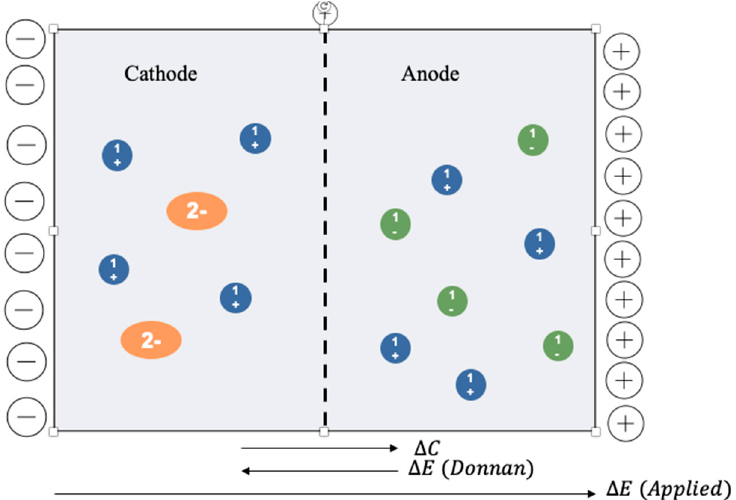
Figure 7. Schematic representation of the electrolytic cell and the main driving forces across the membrane: concentration gradient, Donnan potential, and external voltage applied. Sodium succinate (the orange double negatively charged circles) and sodium (the blue circles) are assumed to be present in the cathode chamber. Locally, the cathode chamber is neutral if no external voltage is applied. In the anode chamber sodium chloride is assumed to be present, with negatively charged chloride ions (the green circles). The anode is locally neutral in the absence of applied voltage.